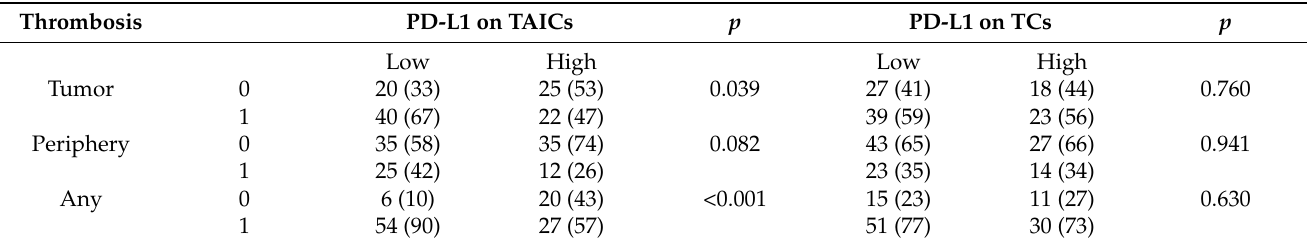
Table 3. Associations between the presence of thrombosis in various compartments and PD-L1 expression on TAICs and TCs.